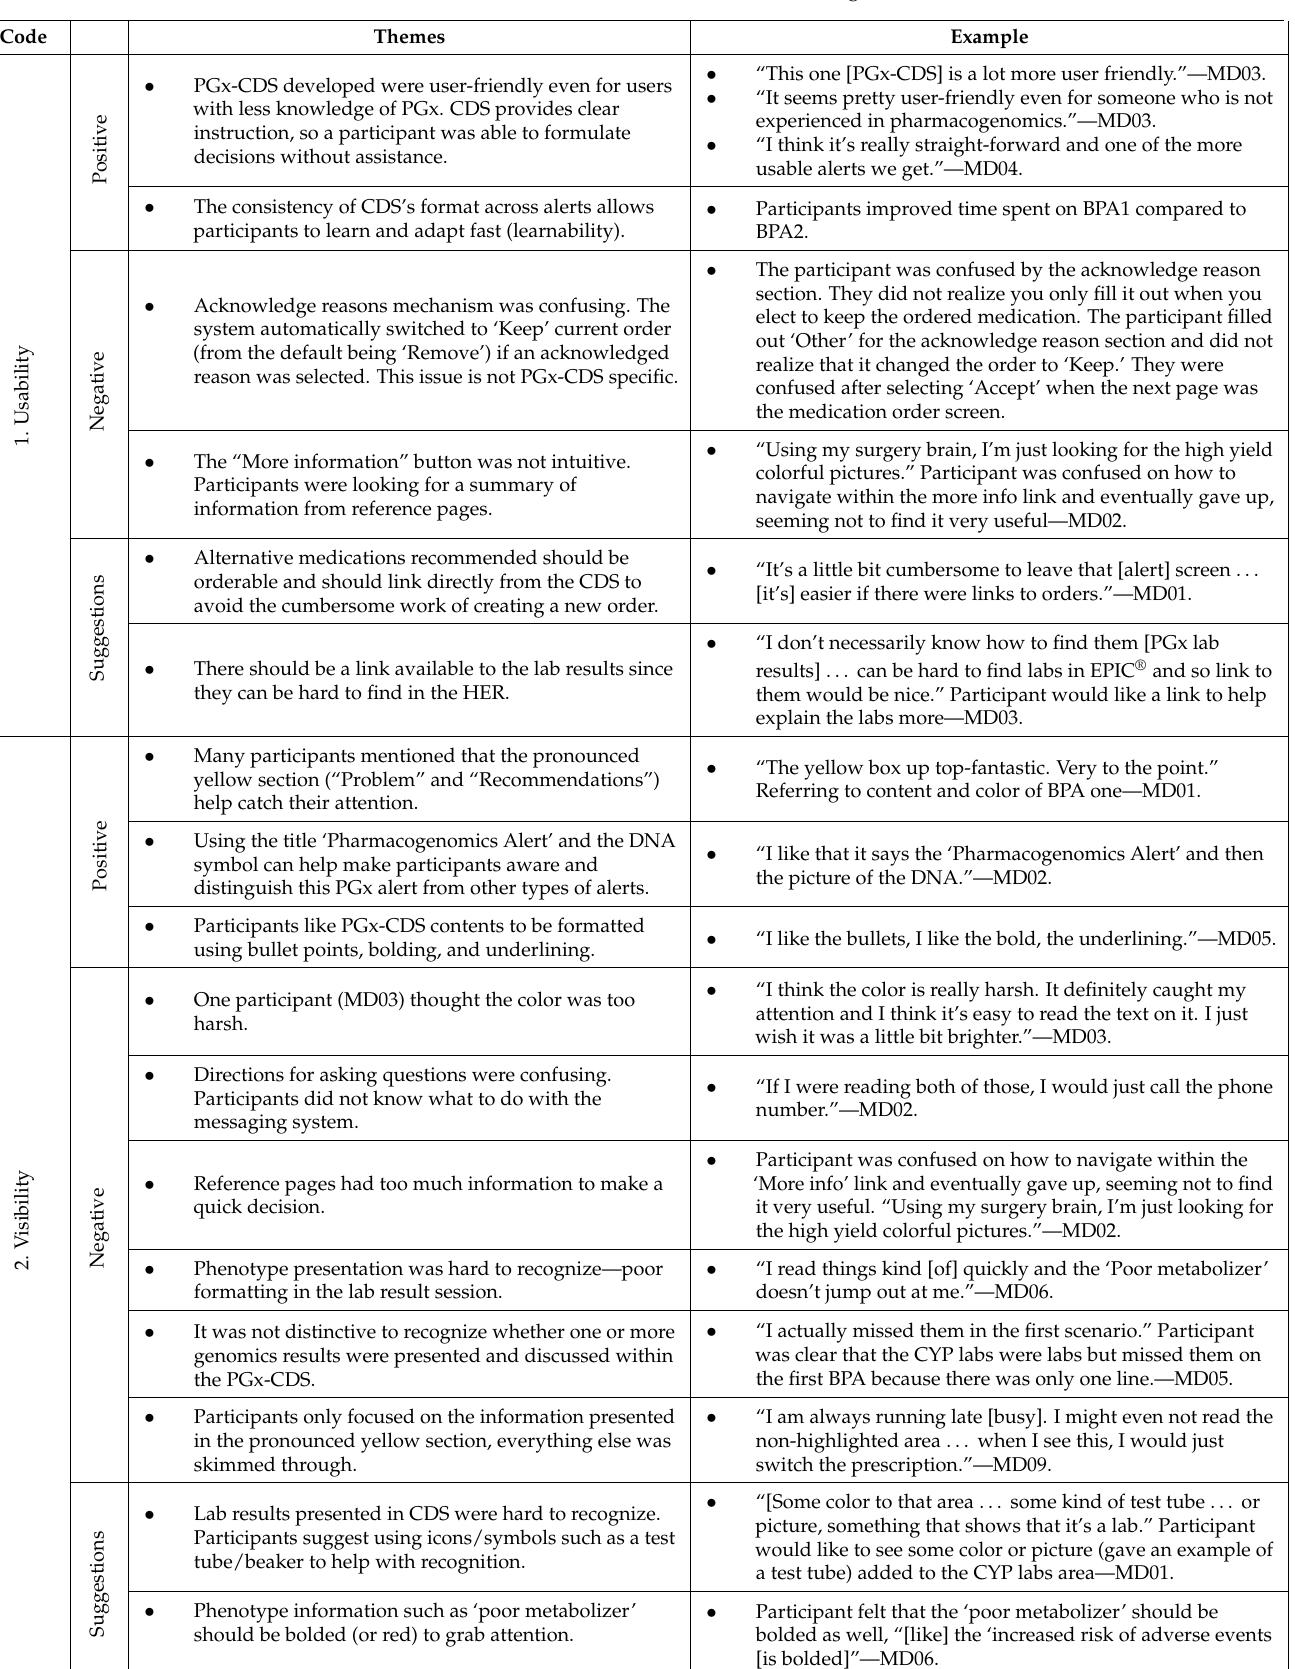
Table 3. Themes collected from the “Think Aloud” session categorized into